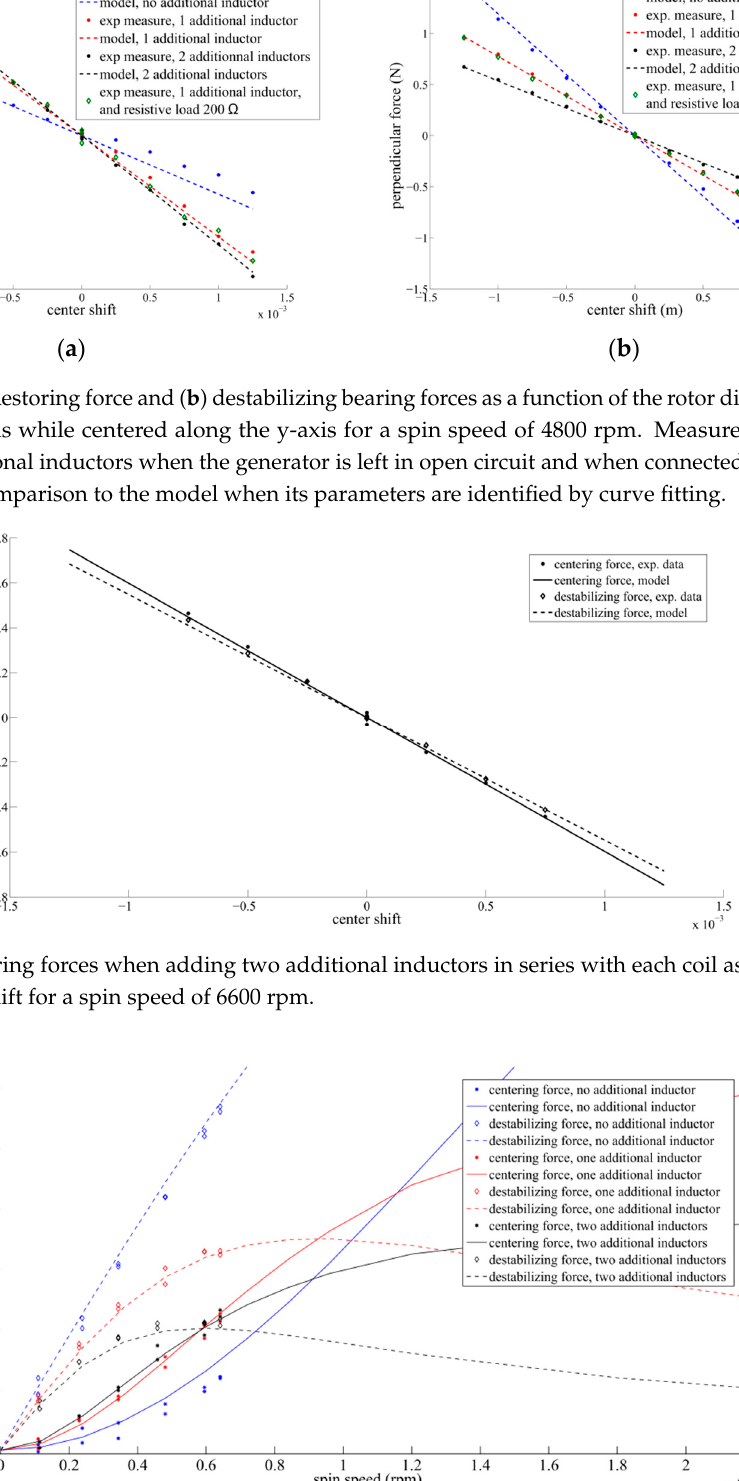
( c ) Figure 22. Theoretical root locus for the electrodynamic bearing prototype dynamic behavior. ( a ) All roots; ( b ) influence of external damping; and ( c ) theoretical root locus for the electrodynamic bearing prototype dynamic behavior when adding two external inductors and influence of external damping. 6.2. Torque The torque is first measured with the generator in open circuit and then with a resistive charge connected to its terminals. It can be observed in Figure 23a that when there is no charge on the motor terminal, torque is measured, which corresponds to the electrodynamic drag torque. This torque increases when the center shift increases. When the resistive charge is connected, an additional torque